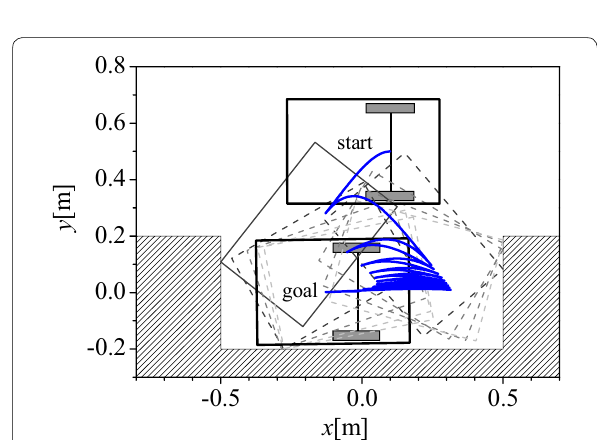
Fig. 6 Numerical simulation result when α is switched as α 1 0.5 = →